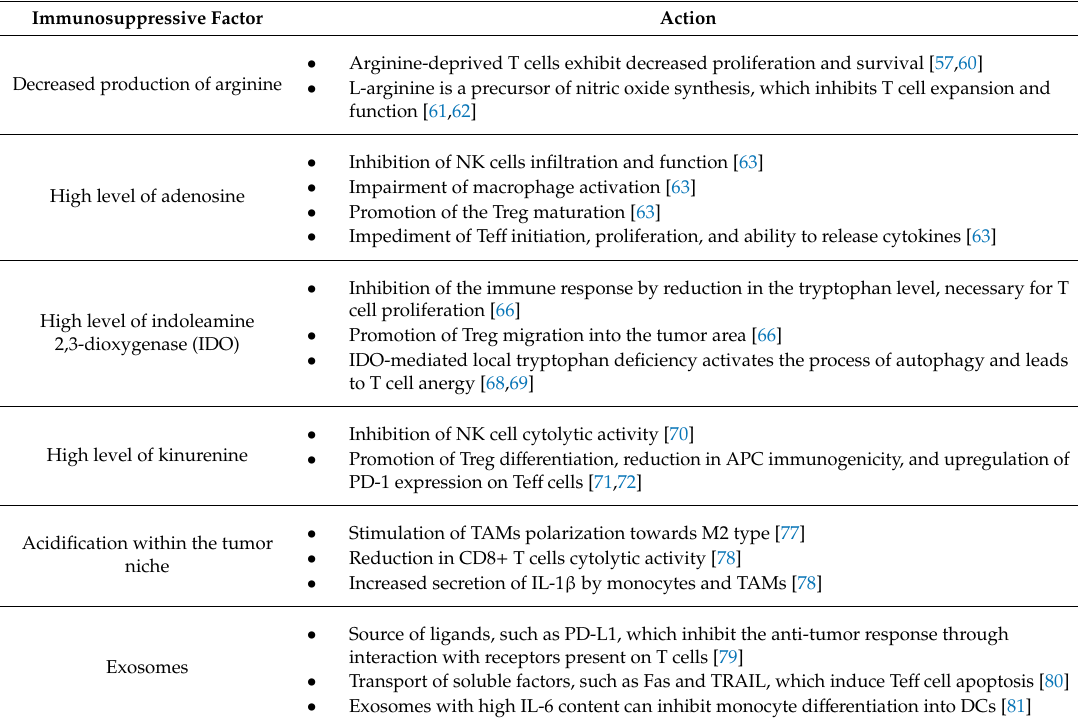
Table 4. Immunosuppressive factors used by cancer cells to escape immune system